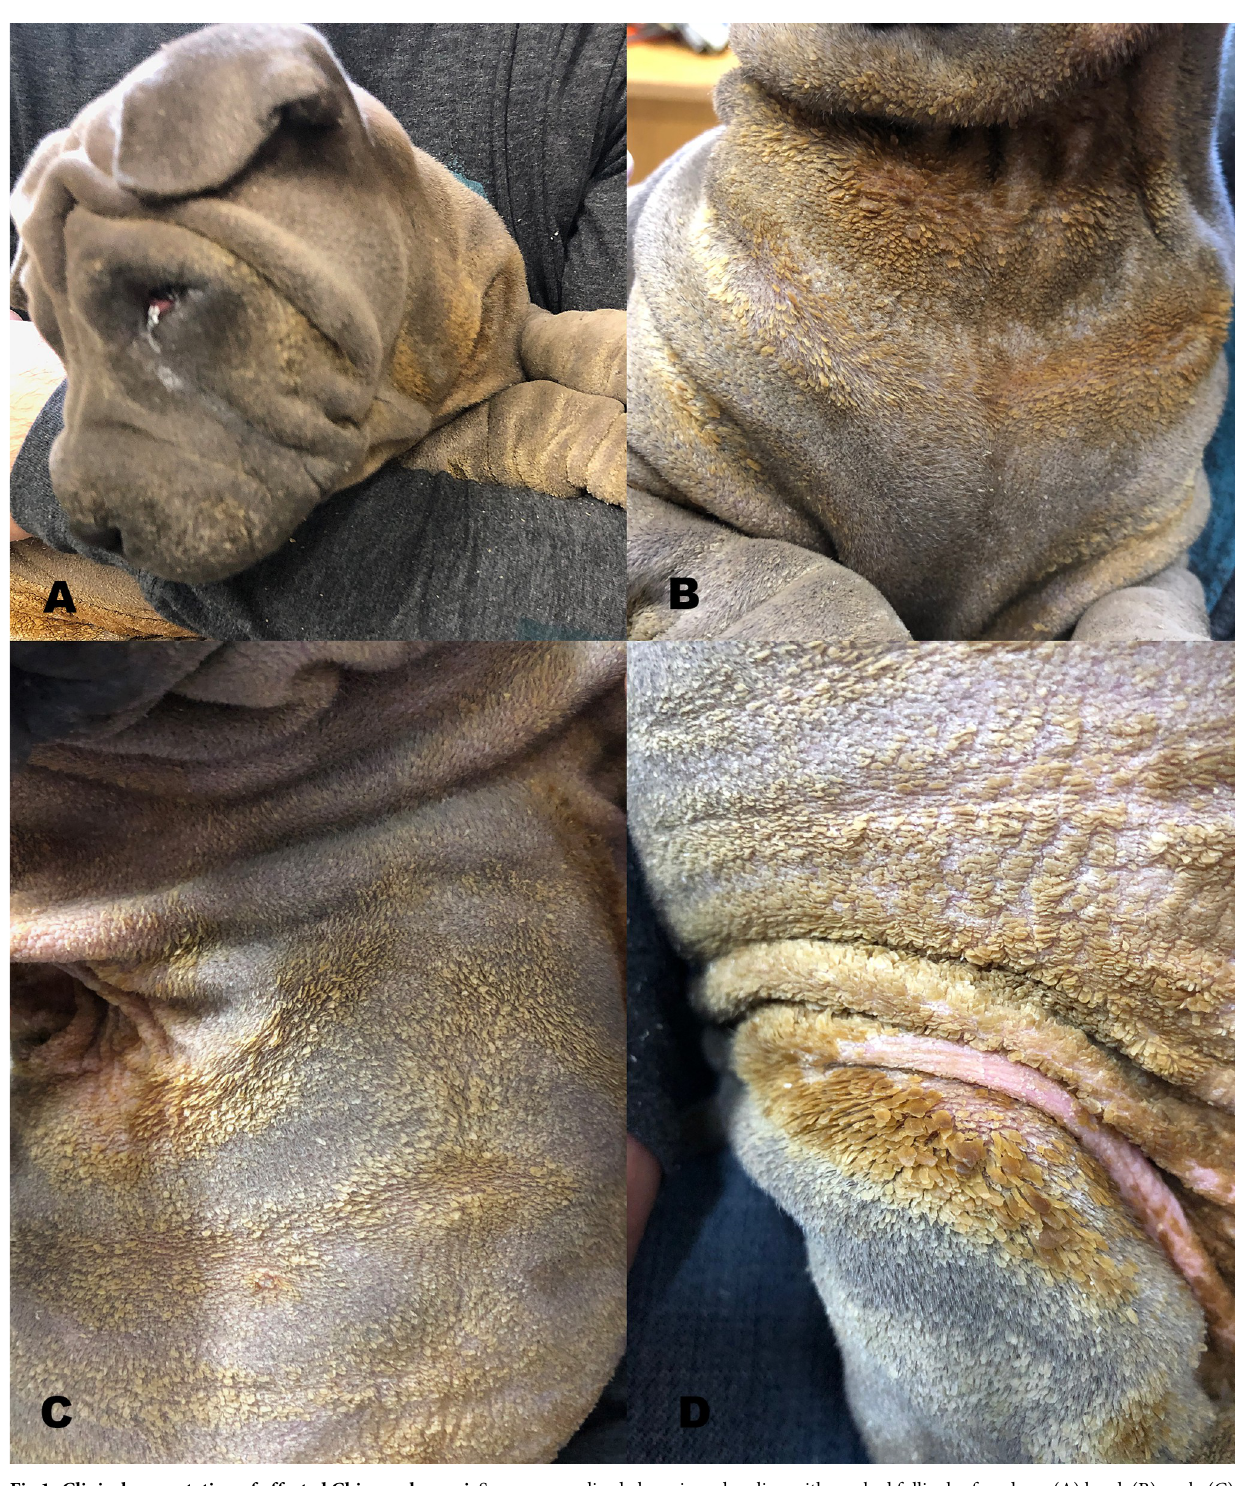
Fig 1. Clinical presentation of affected Chinese shar-pei. Severe generalized alopecia and scaling with marked follicular fronds on (A) head, (B) neck, (C) abdomen and (D) axillary folds.